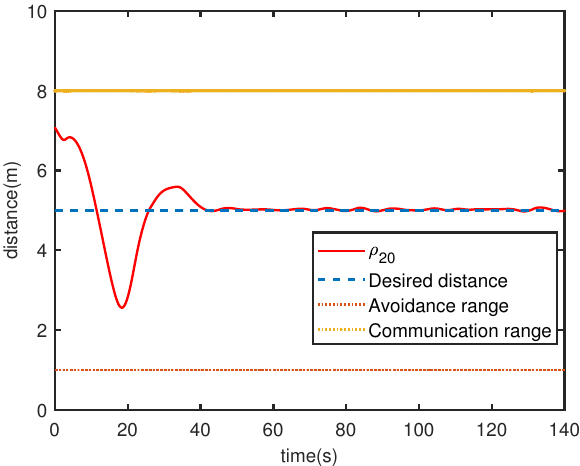
Figure 5. Distance between the leader and USV 2.